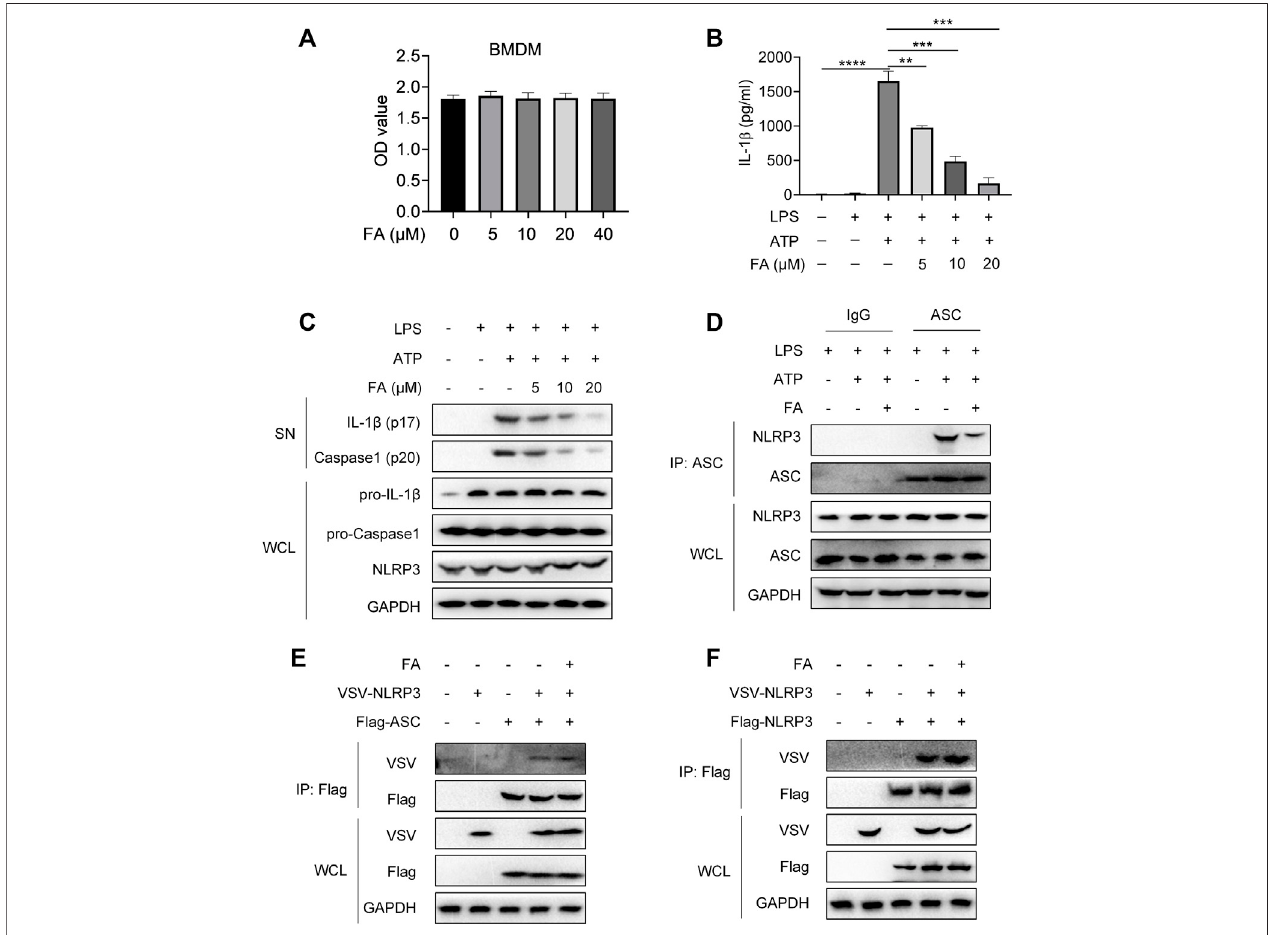
FIGURE9| FAdoesnotaffecttheinteractionbetweenNLRP3andASCorNLRP3.LPS-primedBMDMsweretreatedwithvariousconcentrationsofFA(20 μ M)for 15 min and then stimulated with ATP for 30 min. (A) Expression of IL-1 β in each group after treatment with different concentrations of FA, detected by ELISA. (B) Western blotting detection of the expression of IL-1 β and caspase-1 (P20) in cell supernatants (SN), and pro-IL-1 β and pro-caspase-1 in total protein. (C) CCK-8 detectionoftheeffectsofdifferentconcentrationsofFAontheviabilityofBMDMs. (D) EndogenousIPwithASCantibodyorIgG,performedinLPS-primedBMDMs stimulatedwithATPinthepresenceorabsenceofFA(20 μ M). (E) IPandwesternblotanalysisofNLRP3andASCinteractioninthepresenceorabsenceofFA(20 μ M)in HEK-293T cells. (F) IP and western blot analysis of NLRP3 and NLRP3 interaction in the presence or absence of FA (20 μ M) in HEK-293T cells. Data from three independent experiments or are representative of three independent